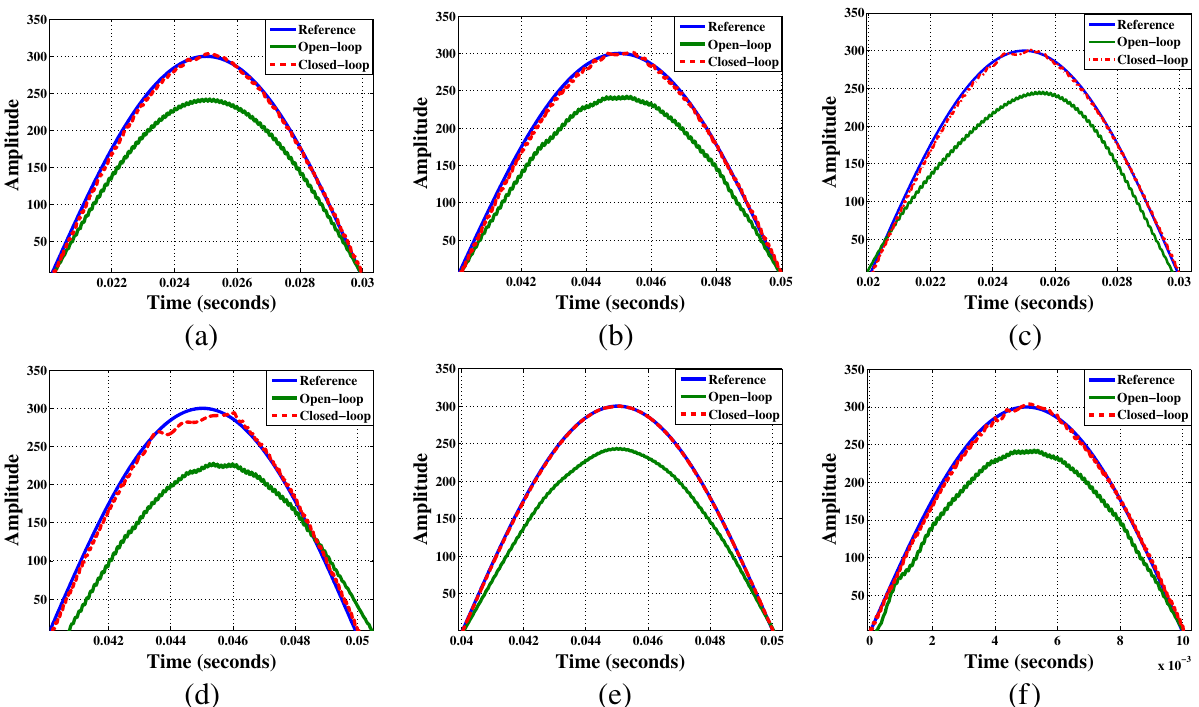
Fig. 17 Grid Voltage Tracking Using ILQG Controller for ( a ) Consumer Load, ( b ) Dynamic Load, ( c ) Harmonic Load ( d ) Asynchronous Machine Load, ( e ) Unknown Load, ( f ) Non-linear Load. The Blue (-) and Green (-) Solid Line Represents the Reference and Open-loop Voltage Respectively and Red (- -) Dotted Line Represents the Closed-Loop Grid